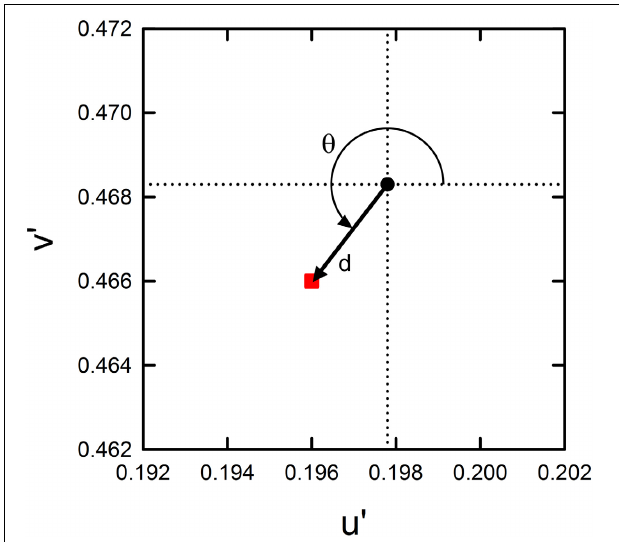
FIGURE 3 | Quantification of color cancelation data. Using the color vector illustrated by the arrow originating at the background white (black